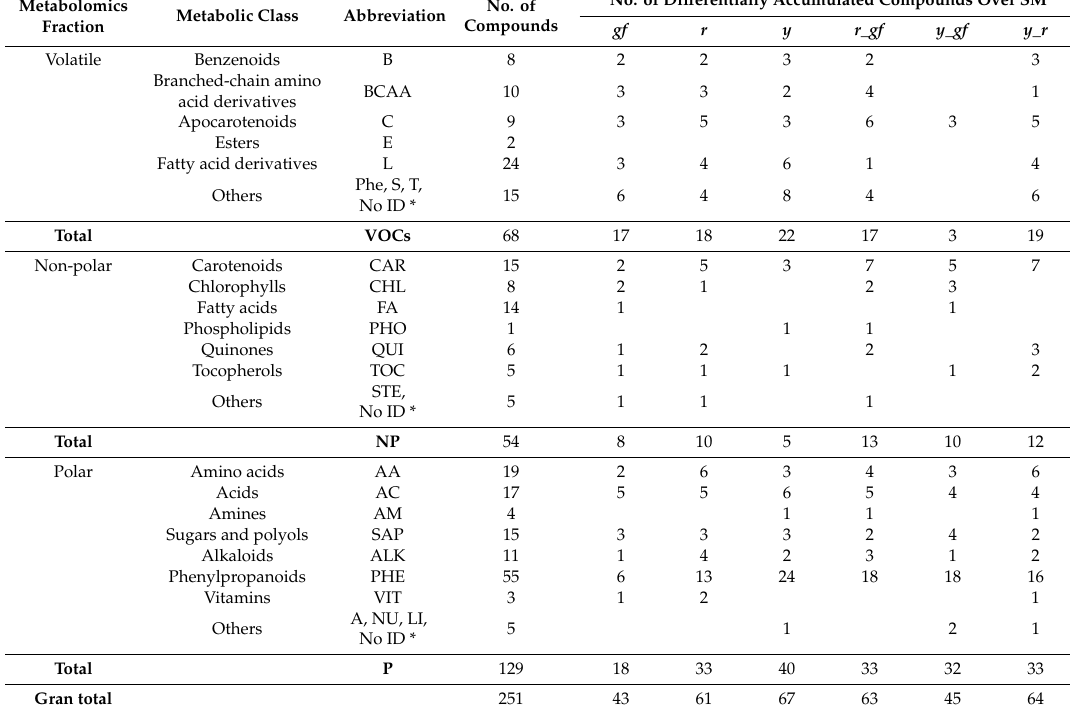
Table 2. Number of compounds in the di ff erent categories and classes of metabolites that are significantly di ff erent from San Marzano (SM) in each of the six lines under